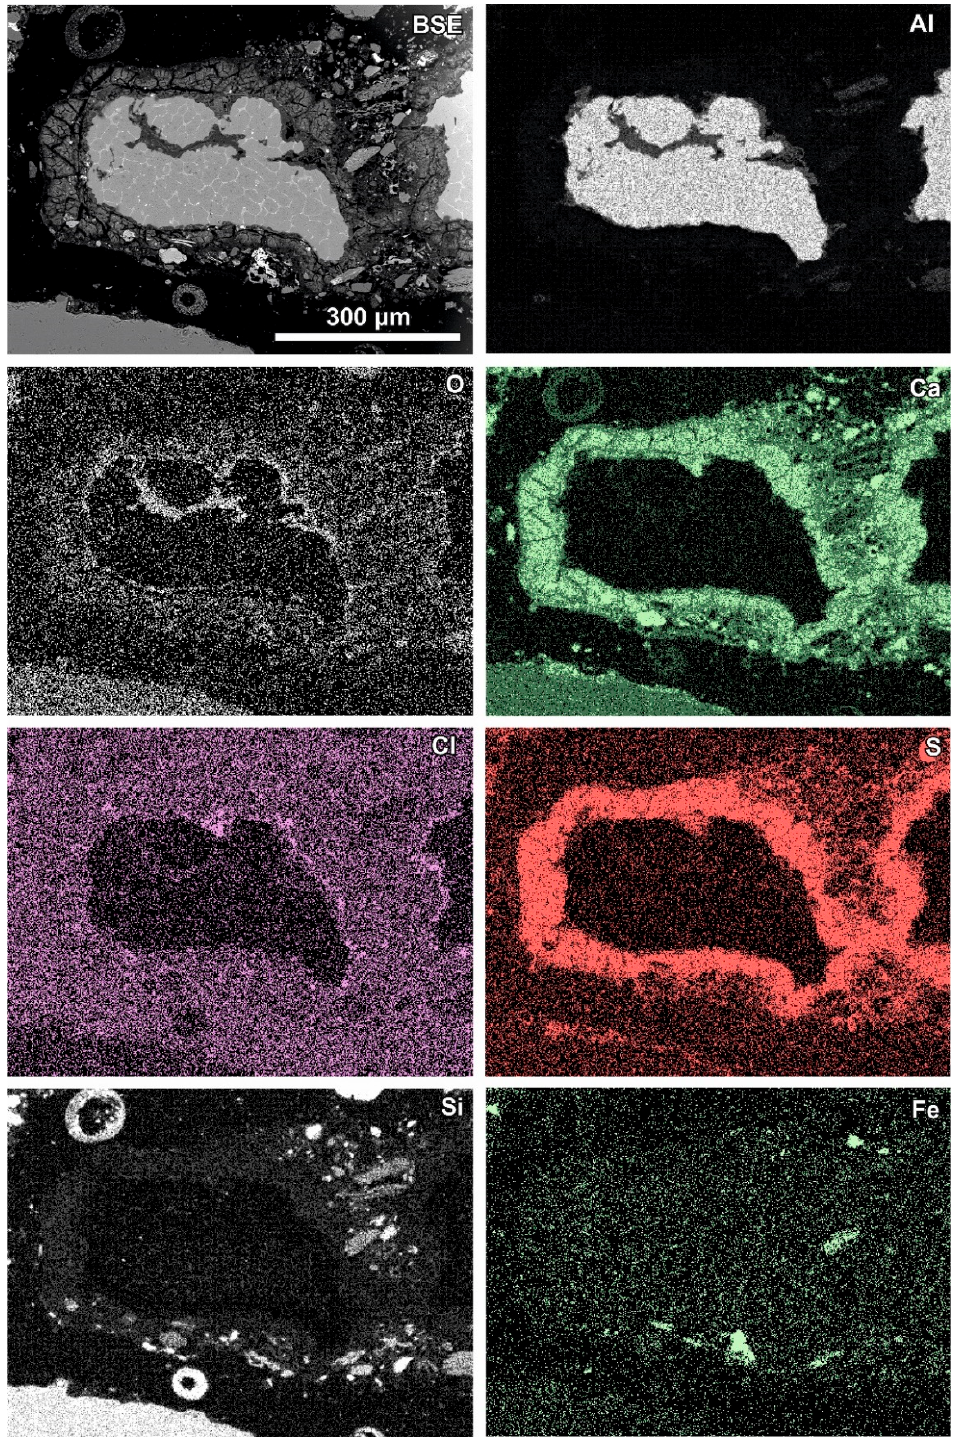
Figure 6. SEM BSE image of the reaction zone and distribution of selected elements—sample RZ3.